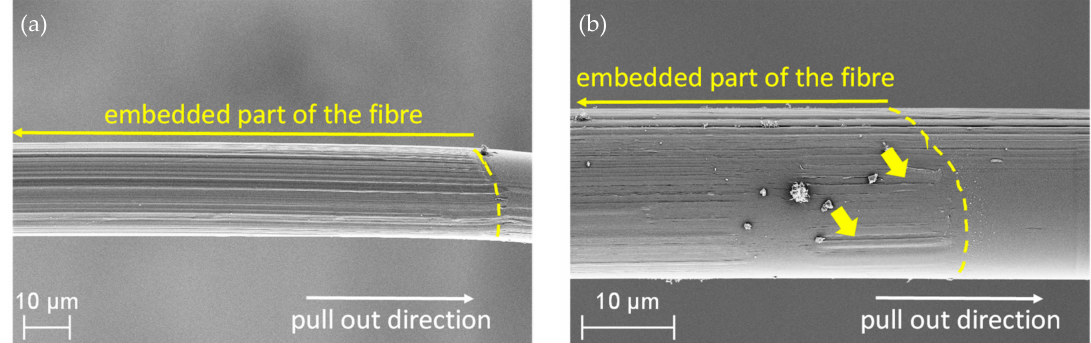
Figure 9. SEM images showing deformations on PP fiber surfaces for ( a ) fiber C20 after quasi-static pull-out and ( b ) fiber C20+ after dynamic pull-out, the arrows highlight grooves caused by surface